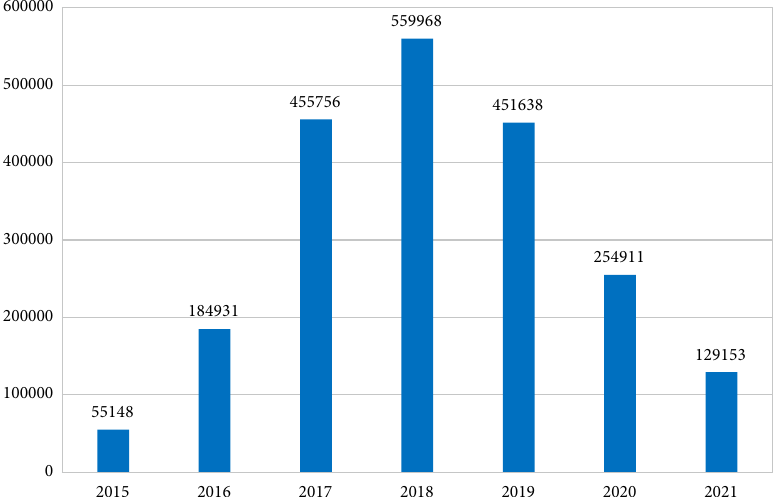
Figure 6. Average annual volume of turnover carried out in the system between 2015 and 2021 (in Zielony) (source: own elaboration based on Stępnicka et al., 2021; data obtained from the administrator of the Zielony complementary currency system in